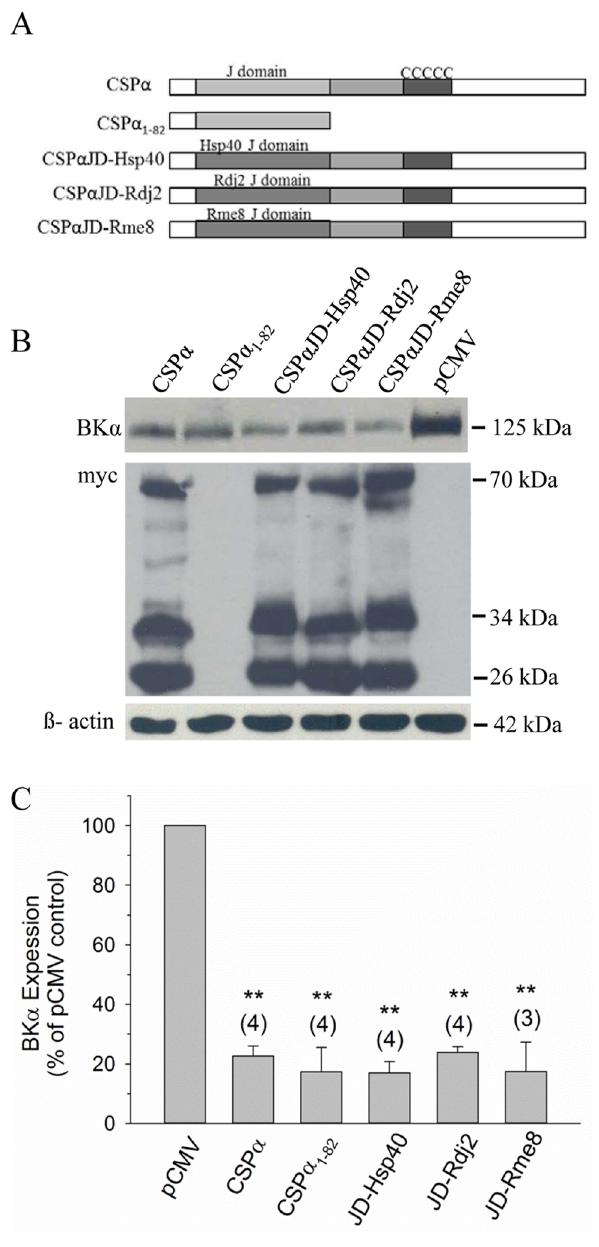
Figure 4. CSP a chimeras with substituted J domains alter BK channel expression. A. Schematic of wild-type CSP a and CSP a chimeras in which the J domain of CSP a is replaced by the J domain of the related J proteins Hsp40, Rdj2 or Rme8. B. Western blot analysis of